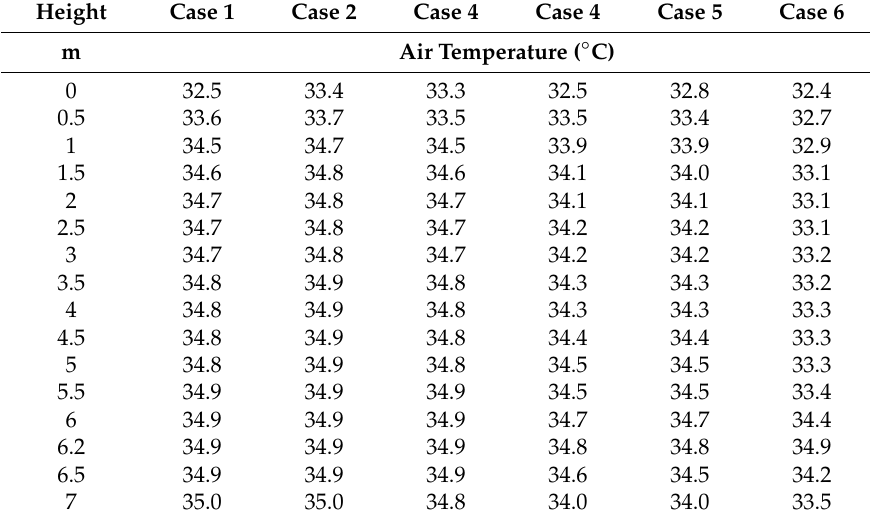
Table 8. Simulated mean air temperature ( ◦ C) outcomes for each case along the 7 m vertical profile. Height Case